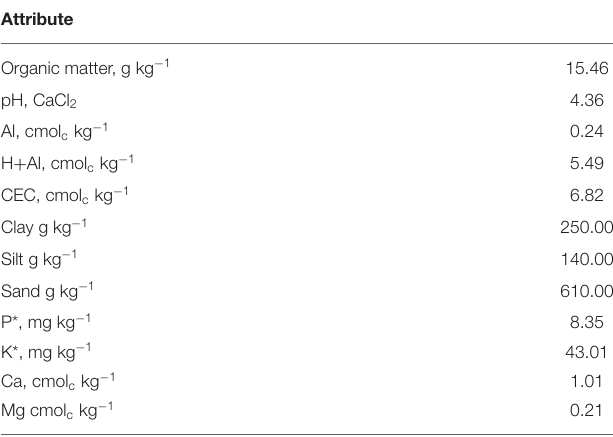
TABLE 3 | Soil chemical and textural